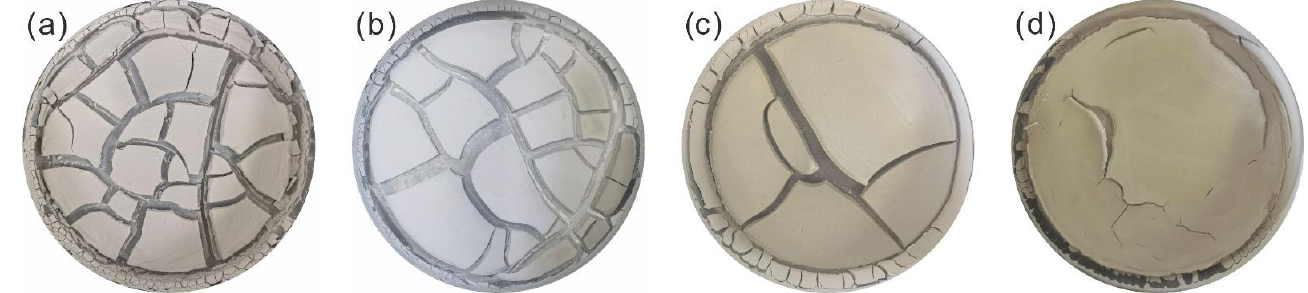
Figure 6. Desiccation crack morphology under different BM:TC (BM:TC means the content ratio of brittle minerals to all clay minerals) conditions. From left to right in the figure are S1, S2, S3, and S4, respectively. ( a ) 10% brittle, 90% clay. ( b ) 30% brittle, 70% clay. ( c ) 50% brittle, 50% clay. ( d ) 70% brittle, 30% clay. (The diameter of the sample is 24 cm).